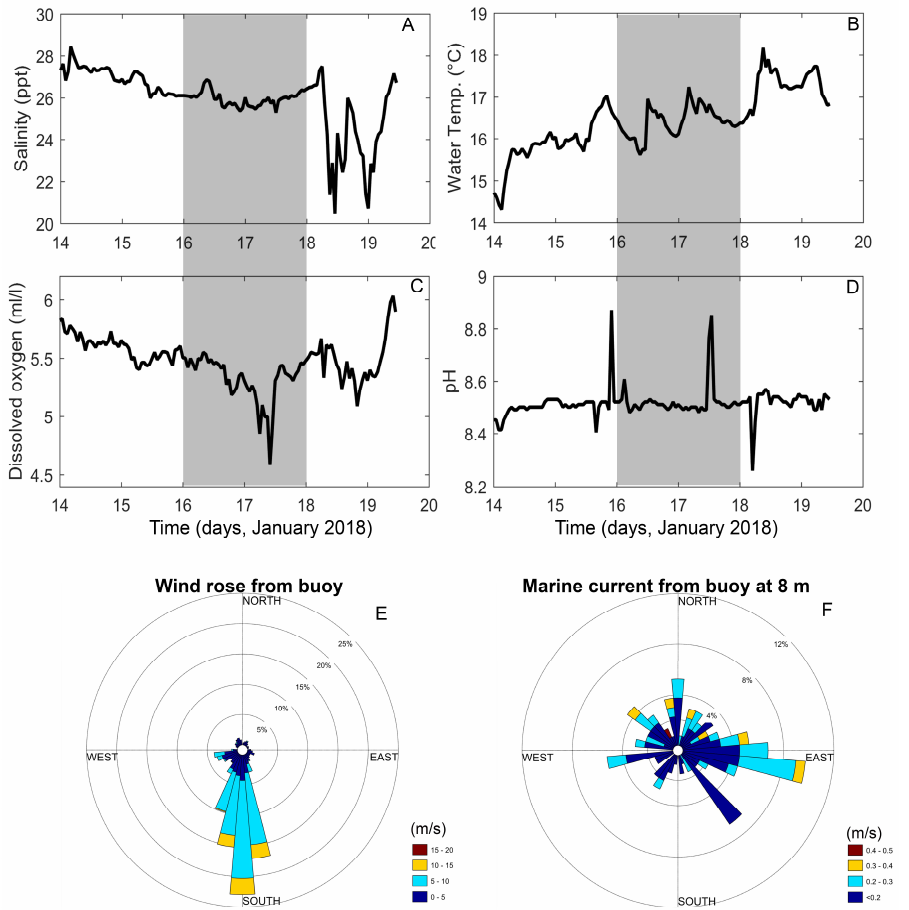
Figure 2. Oceanographic and meteorological variables from a buoy deployed in Reloncaví Sound during January 2018. ( A ) Salinity; ( B ) water temperature; ( C ) dissolved oxygen; ( D ) pH; ( E ) wind direction and velocity; ( F ) current direction and velocity. Shaded areas in figures A–D correspond to the sampling period.